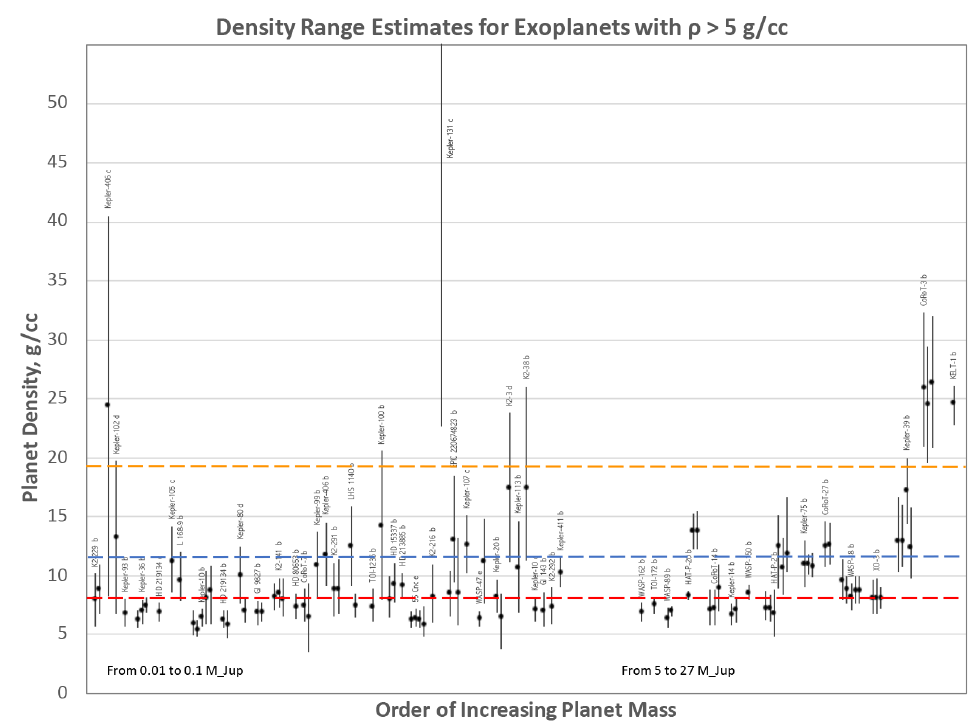
Figure 7. Estimate details for planets with ρ > 5 g/cc. Data from [56], accessed on November 28, 2020. Colored lines show densities (g/cc): red—Fe (7.9), blue—Pb (11.4), yellow—Au